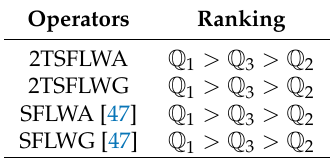
Table 7. Comparative